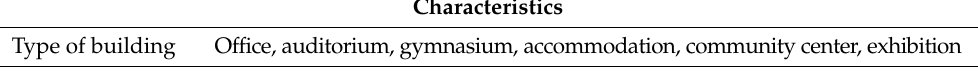
Table 2. Building description.